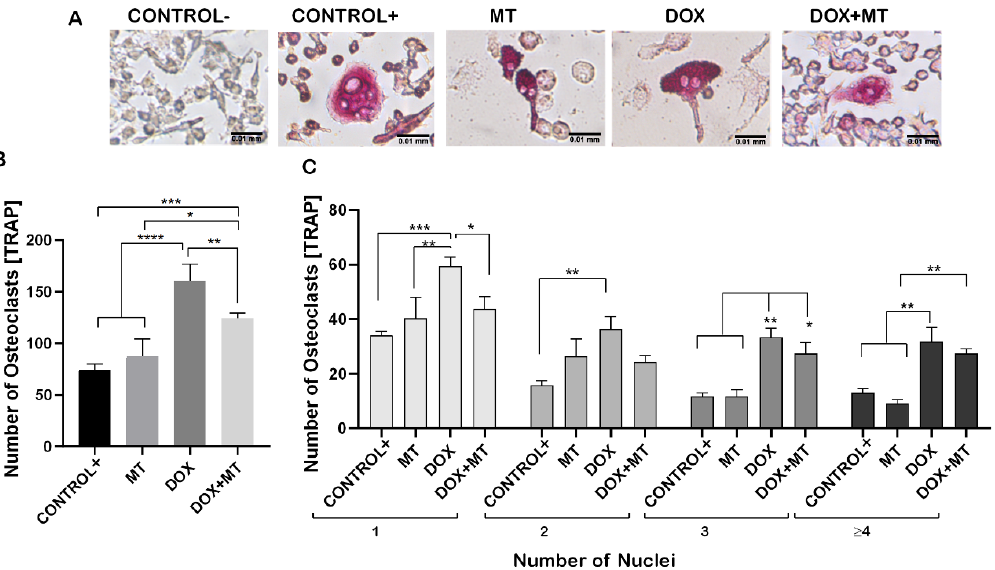
Figure 5. Effect of MitoTEMPO on doxorubicin-induced osteoclast differentiation. RAW 264.7 cells were cultured for 4 days with M-CSF (30 ng/mL) and RANKL (50 ng/mL) and treated with MitoTEMPO (MT) and Doxorubicin (DOX) alone or together. The cells were stained for TRAP ( A ). The number of TRAP-positive cells ( B ). Cells were grouped according to number of nuclei: 1, 2, 3 or more than 4 ( ≥4 ) ( C ). One-way ANOVA, Tukey’s multiple comparisons test, *— p ≤ 0.05, **— p ≤ 0.01, ***— p ≤ 0.001, ****— p ≤ 0.0001.